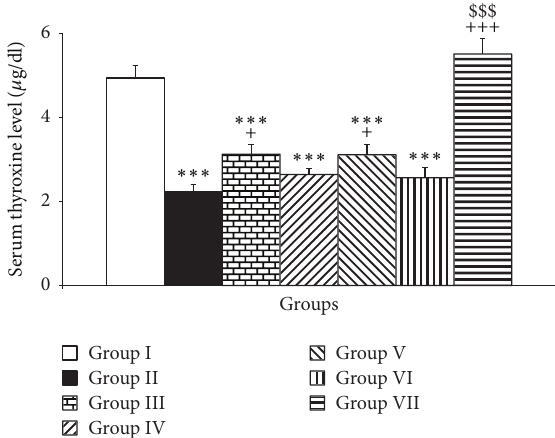
Figure 2: The effects of PTU, Vit E, pioglitazone, and rosiglitazone on cerebellar MDA concentrations. Data are presented as mean ± SEM; 𝑛 = 7 . ∗∗ 𝑃 < 0.01 and ∗∗∗ 𝑃 < 0.001 versus group I; ++ 𝑃 < 0.01 and +++ 𝑃 < 0.001 versus group II; $$$ 𝑃 < 0.001 versus group III; &&& 𝑃 < 0.001 compared to group IV; ### 𝑃 < 0.001 and ## 𝑃 < 0.01 compared to group VI. The data from different treatment groups were compared by using one way ANOVA followed by post hoc LSD test. Group I (control), the animals received drinking water; group II, the animals received 0.05% propylthiouracil (PTU) in drinkingwater;besidesPTU,theanimalsingroupsIII,IV,V,VI,and VII were injected with 20 mg/kg vitamin E (vit E), 10 or 20 mg/kg pioglitazone, and 2 or 4 mg/kg rosiglitazone,